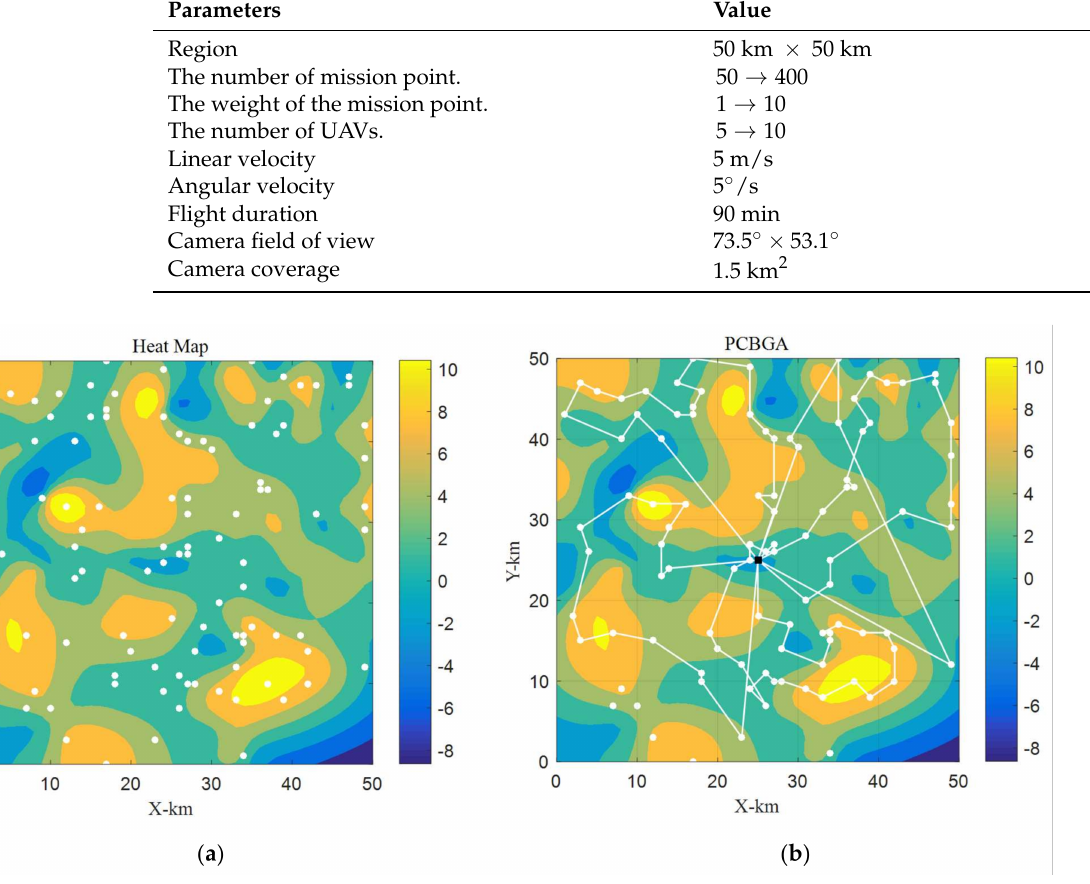
Figure 3. The path planning when N = 100, M = 5. ( a ) Simulation heat map of forest environment; ( b ) Flight paths based on the PCBGA